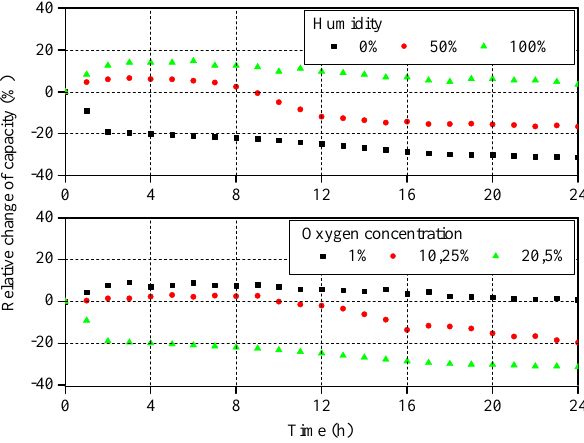
Figure 8. Relative change of capacity by varying the humidity ( ∗ high humidity, non-condensing) under constant oxygen concentration at 20.5% (top) and constant humidity at 0% at various oxygen concentrations (bottom) for a structure diameter ( d ) of 3mm with a path width ( a ) and a distance ( b ) of 40 and 30µm.